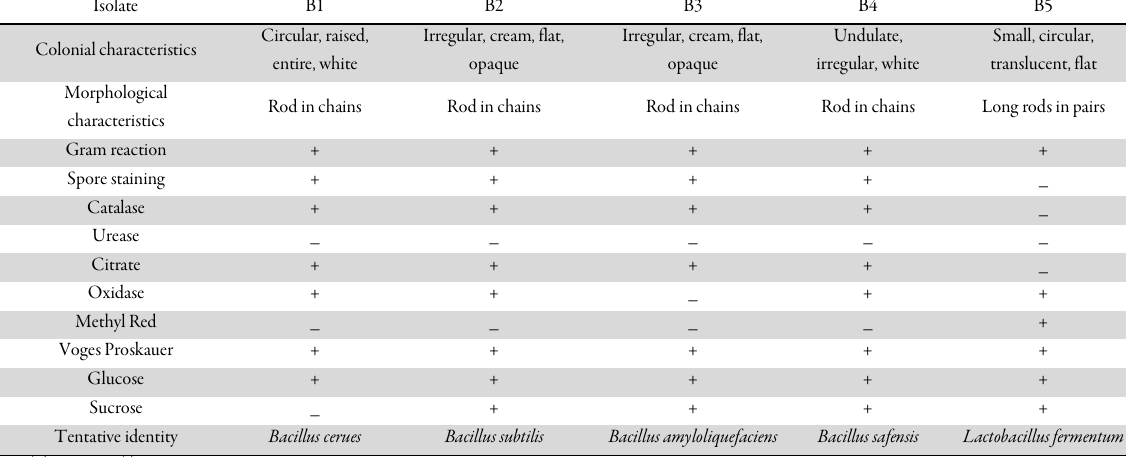
Table 1. The cultural, morphological and biochemical characteristics of bacterial isolates from soymilk samples Isolate